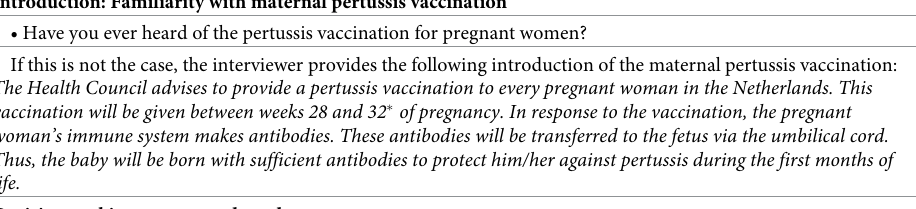
Fig 1. Flowchart of this study’s constructivist grounded theory method.